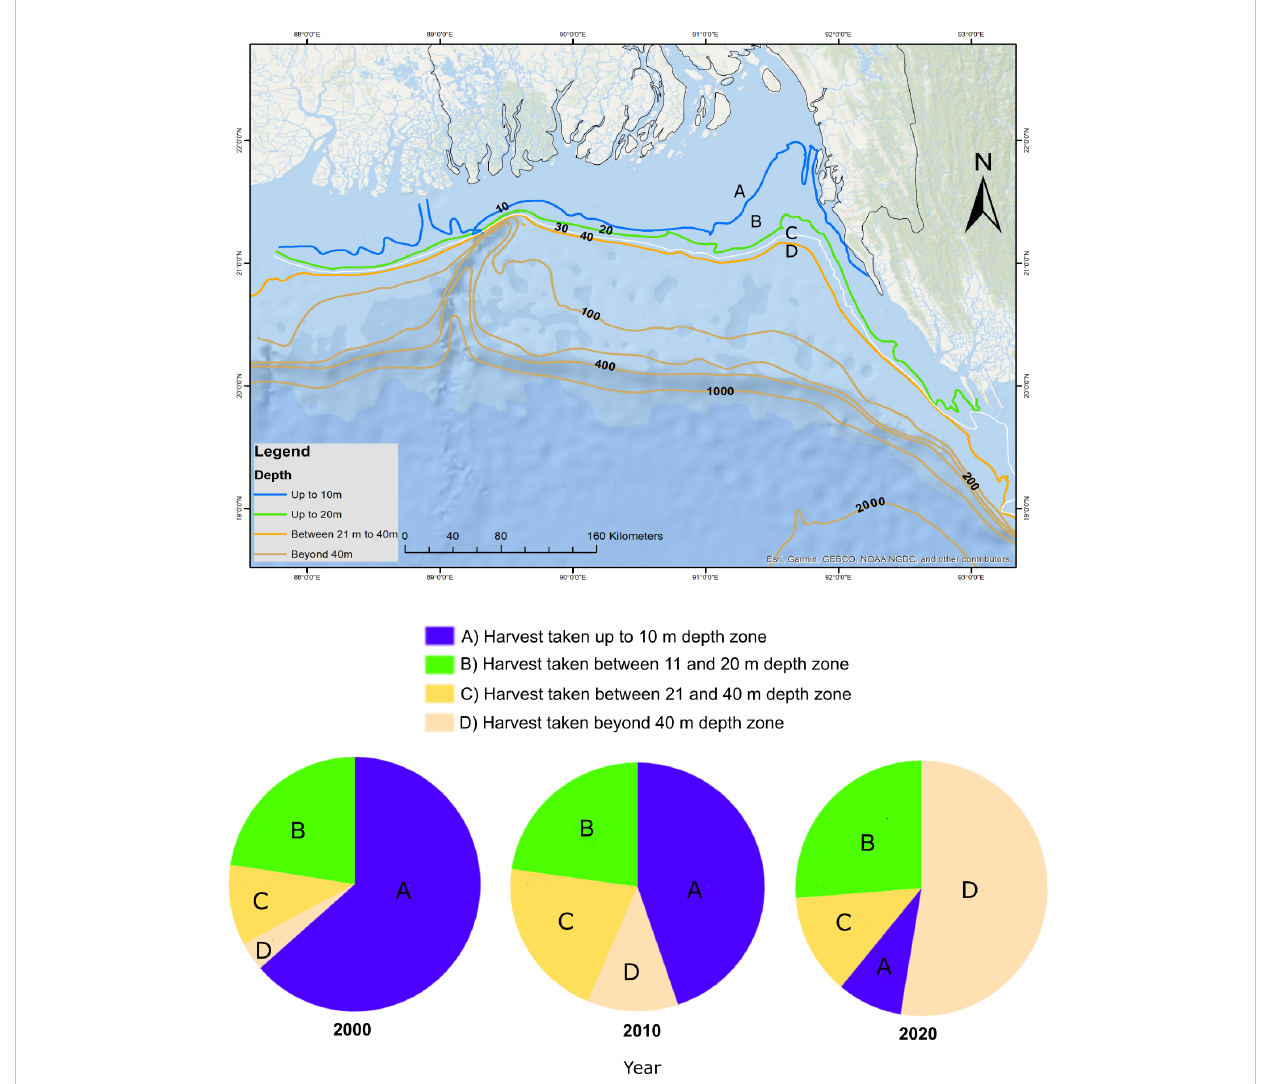
FIGURE 6 Spatial distribution of fi sh harvested by small-scale marine fi shers in four different depth zones of the Bay of Bengal over 20 years. Source: Fishers ’ FGD